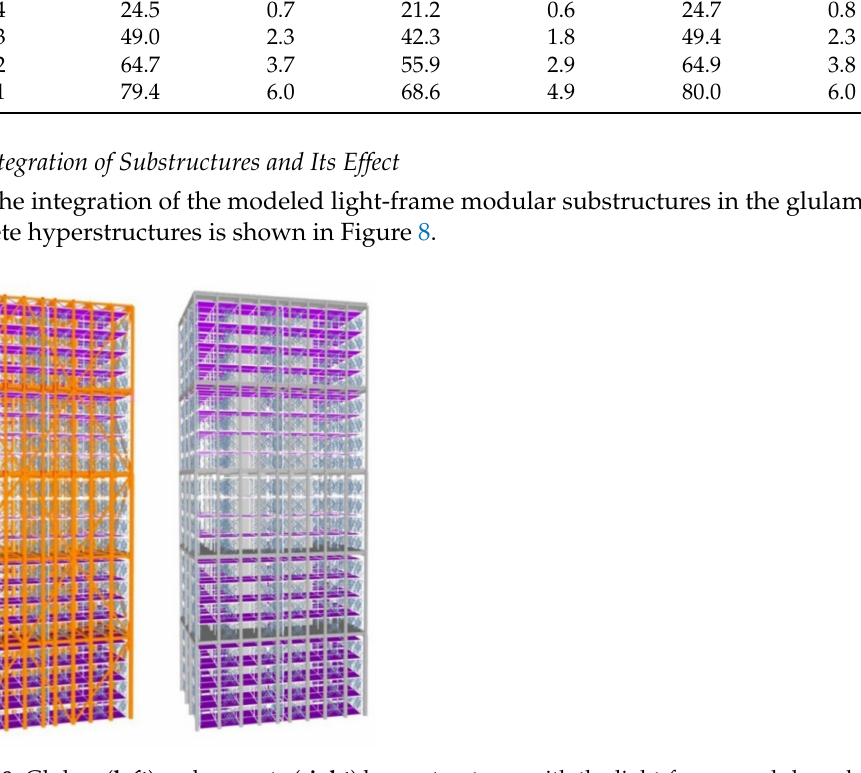
Figure 8. Glulam ( left ) and concrete ( right ) hyperstructures with the light-frame modular substruc- tures integrated.